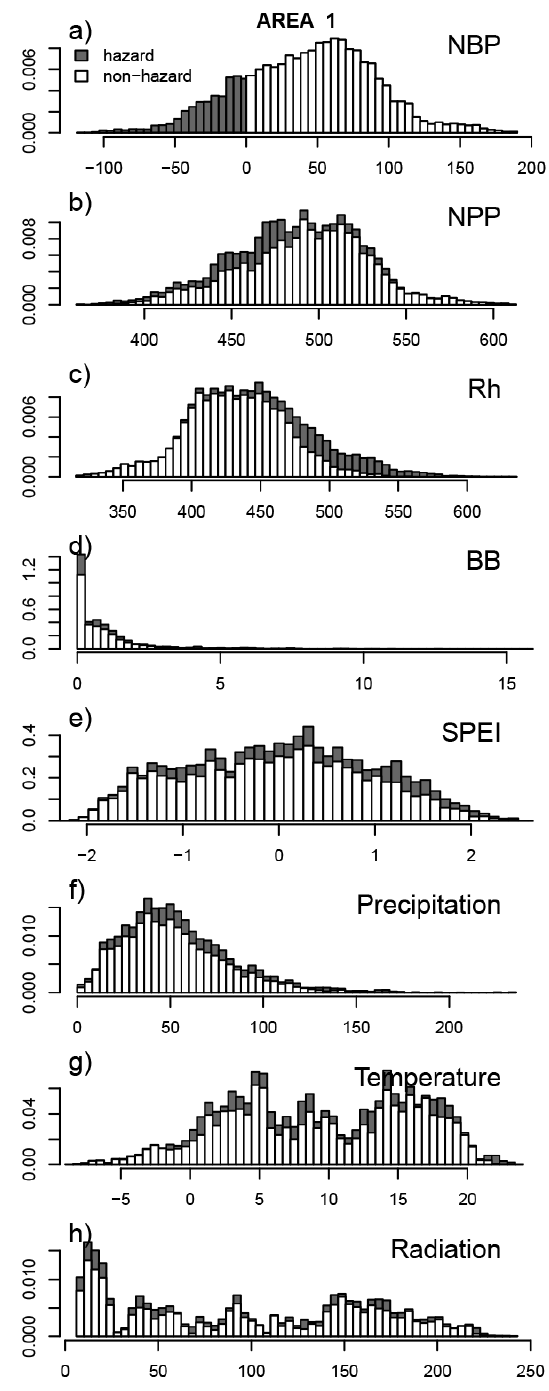
Figure B2. Probability distributions for area 1 (see Fig. B1) of (a) NBP and its contributions (b) NPP, (c) Rh, and (d) BB (all in gCm − 2 a − 1 ) as well as monthly values for (e) SPEI (dimen- sionless), (f) precipitation (mmmonth − 1 ), (g) temperature ( ◦ C) and (h) short-wave downward radiation (Wm − 2 ). Dark shading denotes values in the hazard group, white shading in the non-hazard